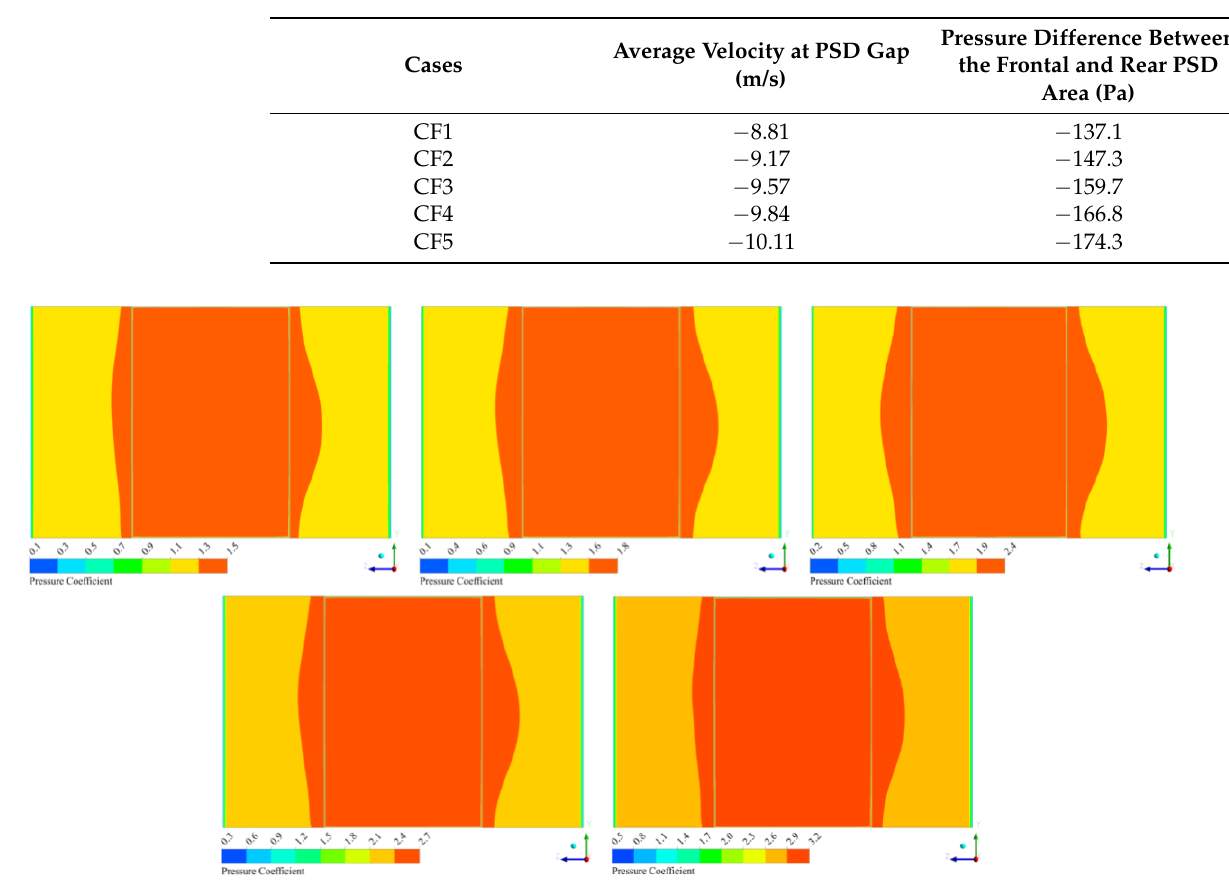
Table 3. Full-scale modeling cases results summary.